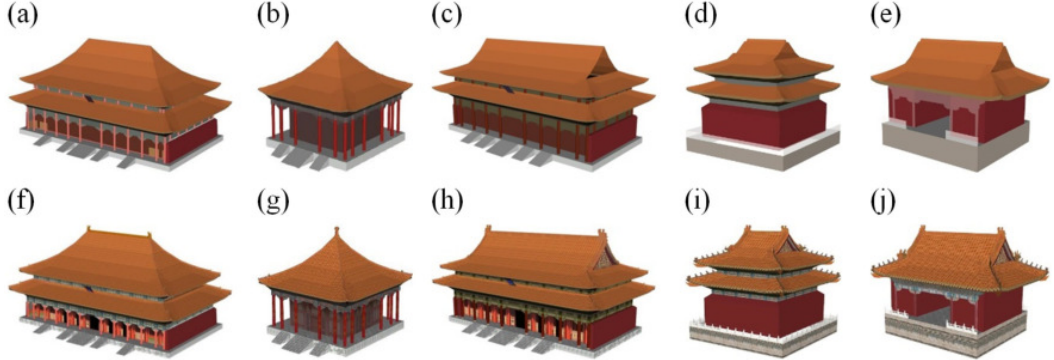
Figure 11. Five palace models displayed in LOD2 ( a – e ) and LOD3 ( f – j ). (Certain textures in LOD3 are highlighted in color; readers are referred to the electronic version of this